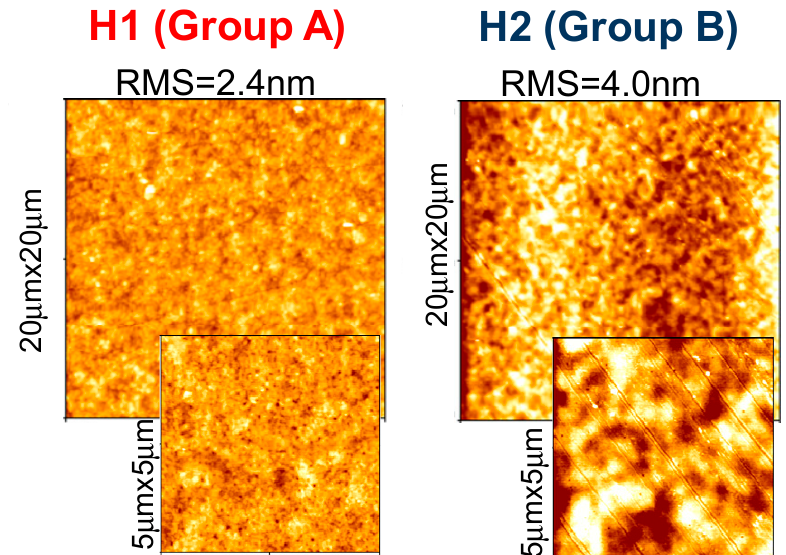
Figure 9. 20 µ m × 20 µ m topographical images, with corresponding zoomed 5 µ m × 5 µ m ones, of Figure 9. 20 μ m × 20 μ m topographical images, with corresponding zoomed 5 μ m × 5 μ m ones, of H1 as representative of Group A, and H2 as representative of Group H1 as representative of Group A, and H2 as representative of Group B.